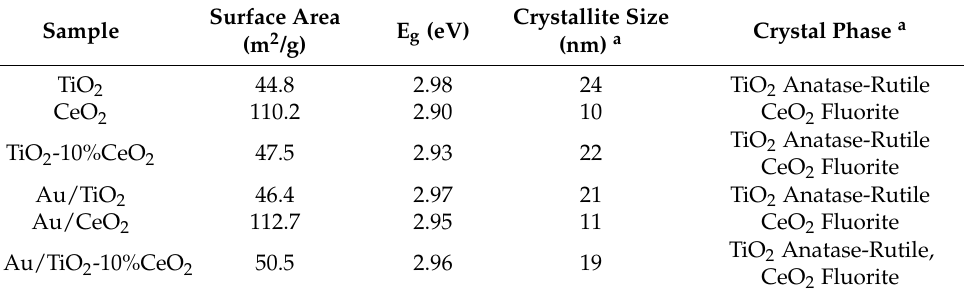
Table 1. Chemico-physical properties of Au/TiO 2 -CeO 2